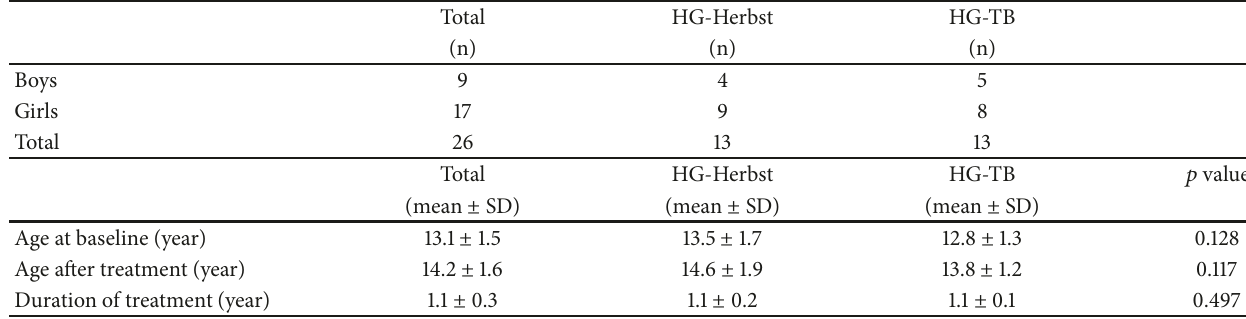
Table 1: Demographic data of the study